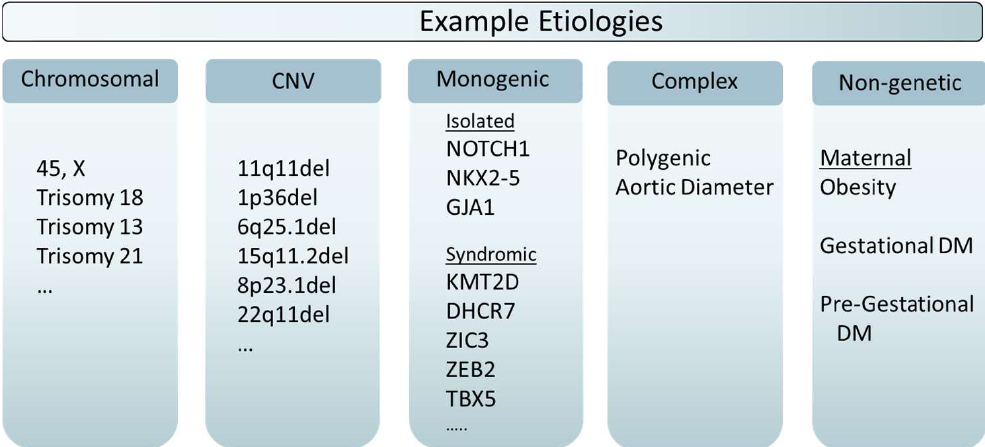
Figure 2. Examples of specific HLHS-associated genetic disorders or risk factors. These lists are not comprehensive and meant only to illustrate some of the more commonly encountered disorders.